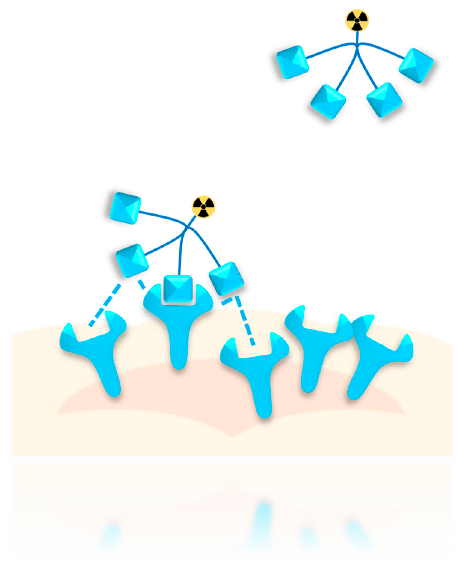
Figure 1. Schematic depiction of the “forced proximity” effect. Considering a peptide multimer having already bound with one peptide to a receptor on the cell surface, unbound peptide copies of the same multimer are located near the cell in close proximity of other free target receptors, increasing the probability of further peptide–receptor interactions or re-binding upon ligand dissociation.